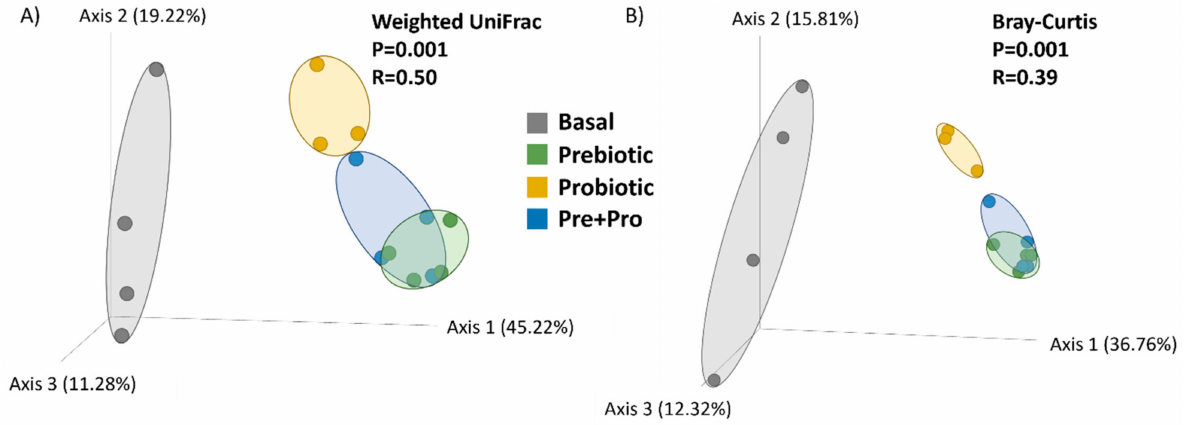
Figure 3. Principal Component Analysis (PCoA) plot based on the weighted UniFrac ( A ) and Bray–Curtis ( B ) as beta diversity metrics. Samples cluster by diet indicating the community structure is affected by diet, which was supported by the results of ANOSIM testing (R = 0.50, p = 0.001,